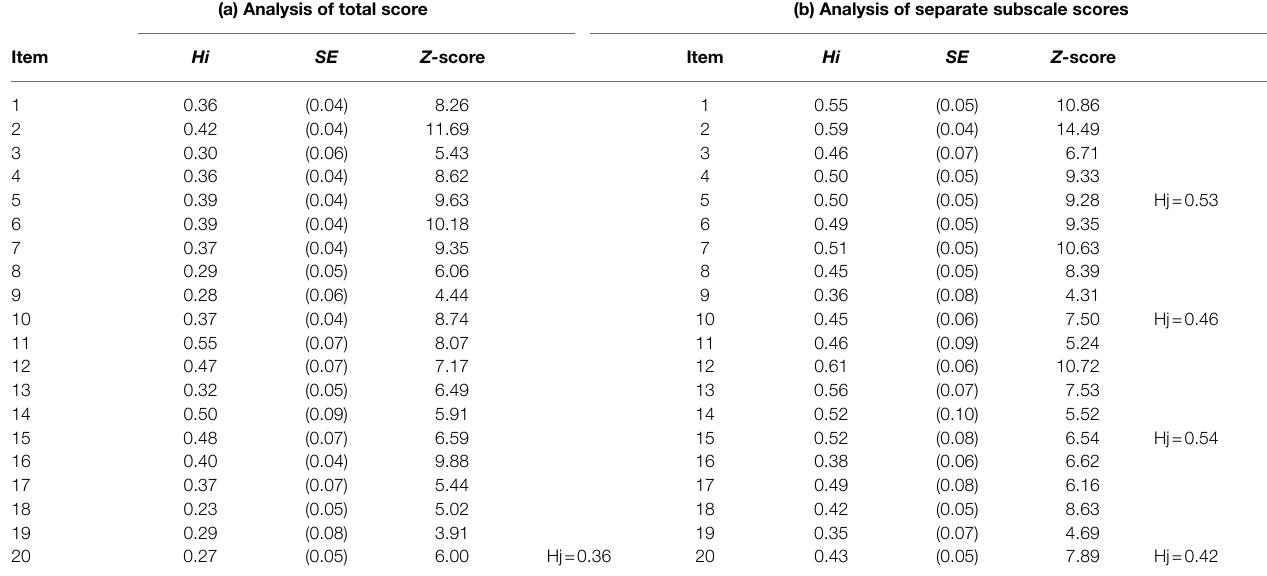
TABLE 5 | Descriptive statistics and intercorrelations among HPSS scores. (a) Analysis of total score (b) Analysis of separate subscale scores